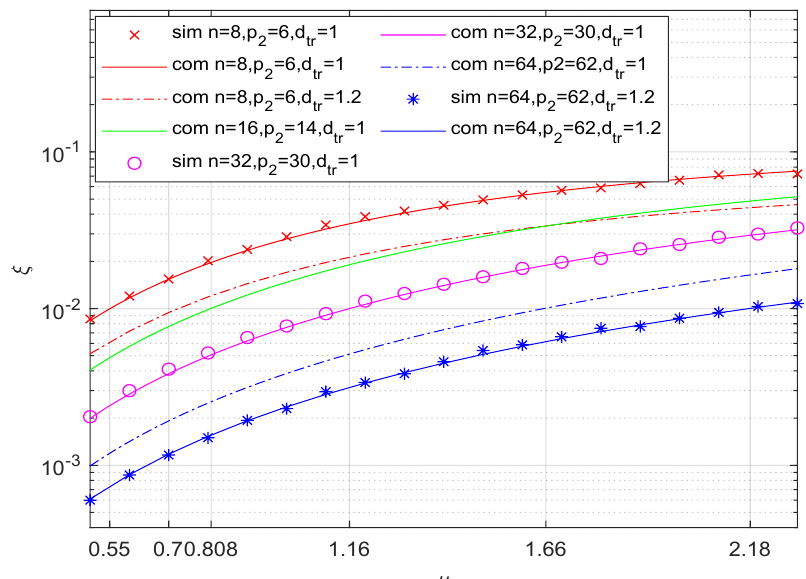
Figure 4. The ratio of the harvested energy to the transmitted energy changes along with µ for GCI-DCSK SWIPT at d tr = 1 and d tr = 1.2, where β 1 = 180 and P s / N 0 = 40 dB.